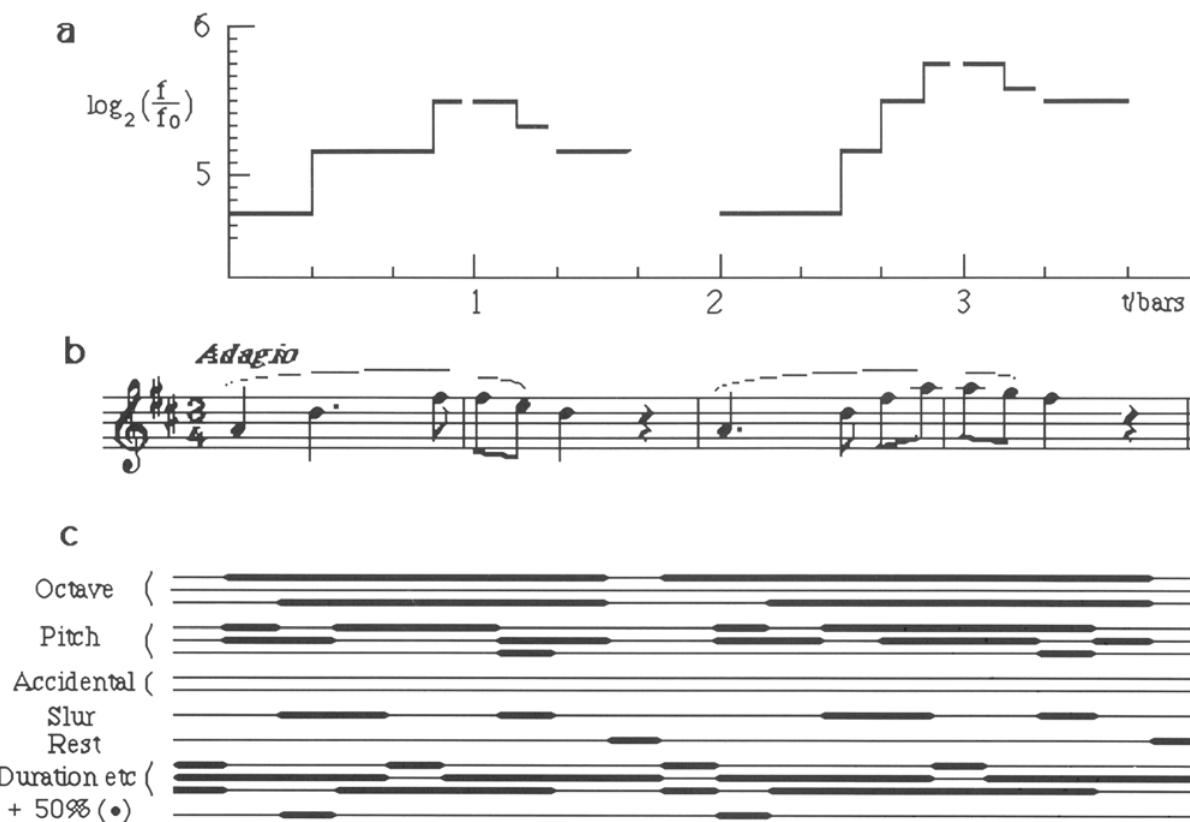
Figure 2. Three ways of coding the first four bars of the theme of the slow movement of Mozart’s clarinet concerto. (a) is a semi-log plot of the pitch frequency as a function of time. On the time axis, the larger tics are bars (measures) and the smaller are beats. On the frequency axis, the larger tics are octaves. Notes an octave apart have the same letter name e.g. C5 and C6. The reference frequency is the note called C0, which is currently about 16.3 Hz. The smaller tics are one twelfth of an octave i.e frequency ratio of 2 1/12 ≅ 1.059). These are called equal-tempered semitones: they correspond to the notes on an electronic keyboard. (b) is essentially traditional notation. The vertical and horizontal axes have been adjusted to make it an exactly semi-log plot by varying the spacing between lines, which may represent 3 or 4 semitones. The shapes of notes are a digitised code for duration that has several advantages over the analog time scale used in (a). (c) is a parsimonious parallel binary coding, which is more akin to traditional notation than to (a). The pitches of notes are shown by their octave (top 3 bits) and the note names (next 3 bits) with the most significant bit at the top. The next 2 bits allow for accidentals (sharps, flats and naturals) that are not needed in this example unless the key signature is omitted. The next bit indicates slurs: whether the note is continu- ous with the preceding one (the curved lines or slurs in (b)). The next bit indicates a rest (silence) of the appropriate length. The next 3 bits show the negative log durations with respect to a whole note. Semibreves, minims, crotchets, quavers and semiquavers (whole, half, quarter, eighth and sixteenth notes) are represented by 000 to 100. 101 is used for a bar line. The final bit allows an increase of 50% in duration (indicated by a dot in (b)). The duration code 111 is reserved as a signal to toggle the coding to text, so that occasional data such as tempo, key signature, expression marks can be added more efficiently. (The unequal spacing of channels is a guide for the eye